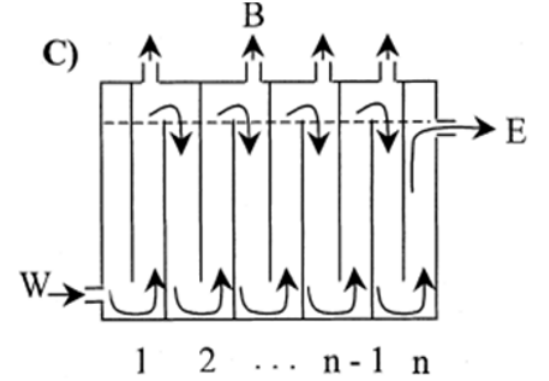
Figure 1. Vertical Baffled Reactor (W= wastewater, B= Biogas, E= Effluent)